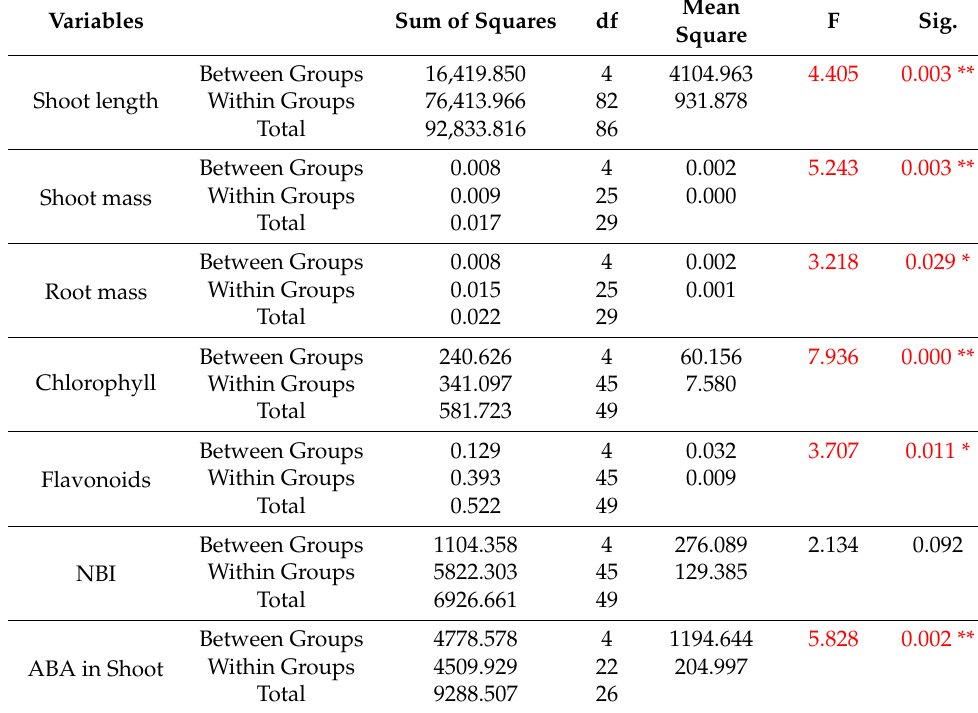
Table 1. One-way ANOVA test of significance in some variables between groups: control plants untreated with either bacteria or HSs and plants grown under water deficit (control, plants treated with Pseudomonas plecoglossicida 2,4-D (2,4-D), humic substances (HSs) and their combinations (2,4-D + HSs). Values in the cells correspond to p for the difference between the mean values; p ≤ 0.05 is marked with *; p ≤ 0.01—with